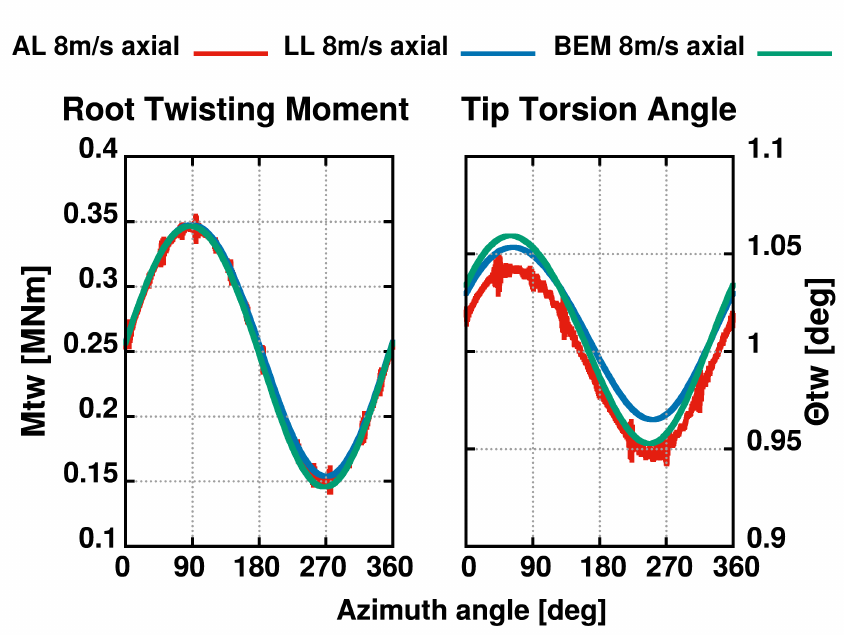
Figure 18. Root twisting moment and tip torsion angle at 8 m/s axial wind